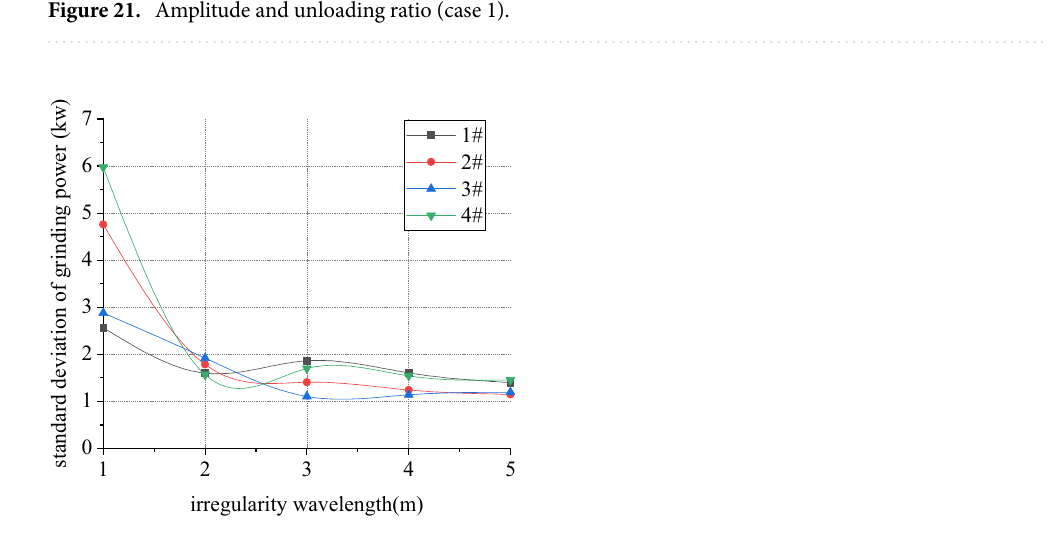
Figure 22. Wavelength and grinding power (case